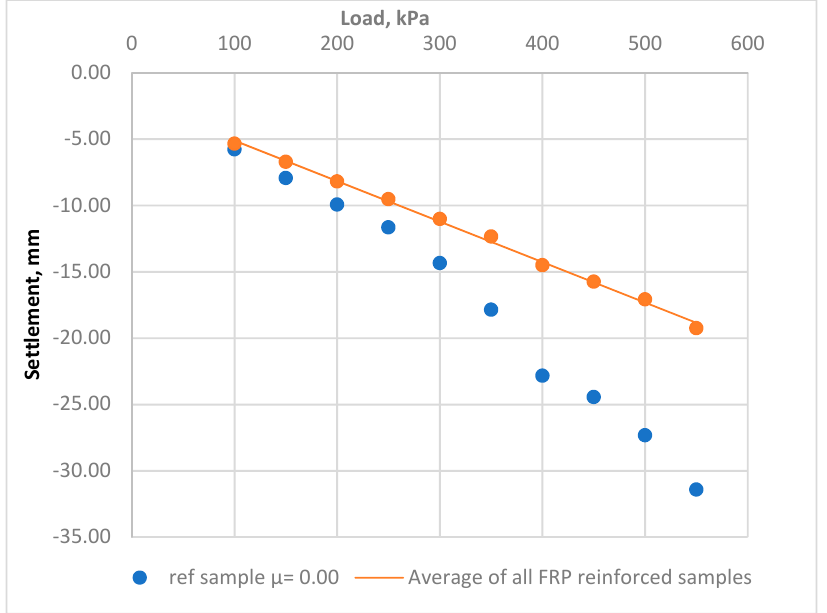
Figure 8. The average elastic load − settlement relationship for all FRP-reinforced soil compared to the reference soil.